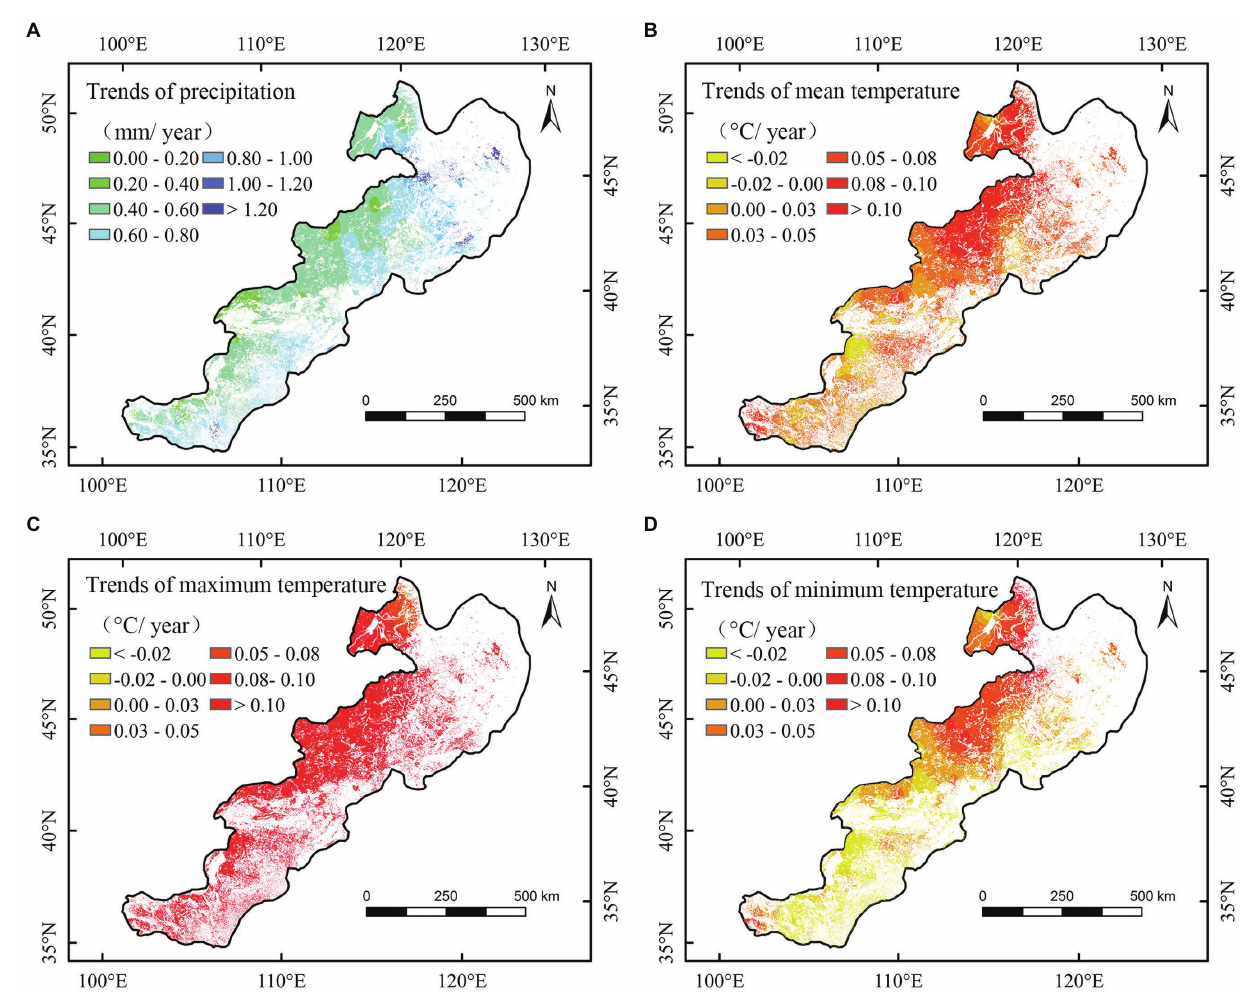
Supplementary Table 1 | Information about climate data in 76 weather